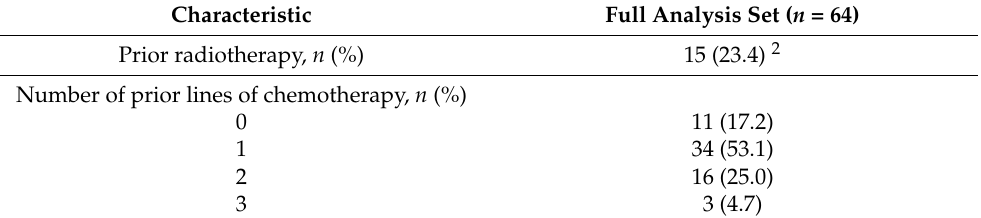
Table 1. Cont. Characteristic Full Analysis Set ( n = 64) Prior radiotherapy, n (%) 15 (23.4) 2 Number of prior lines of chemotherapy, n (%) 0 11